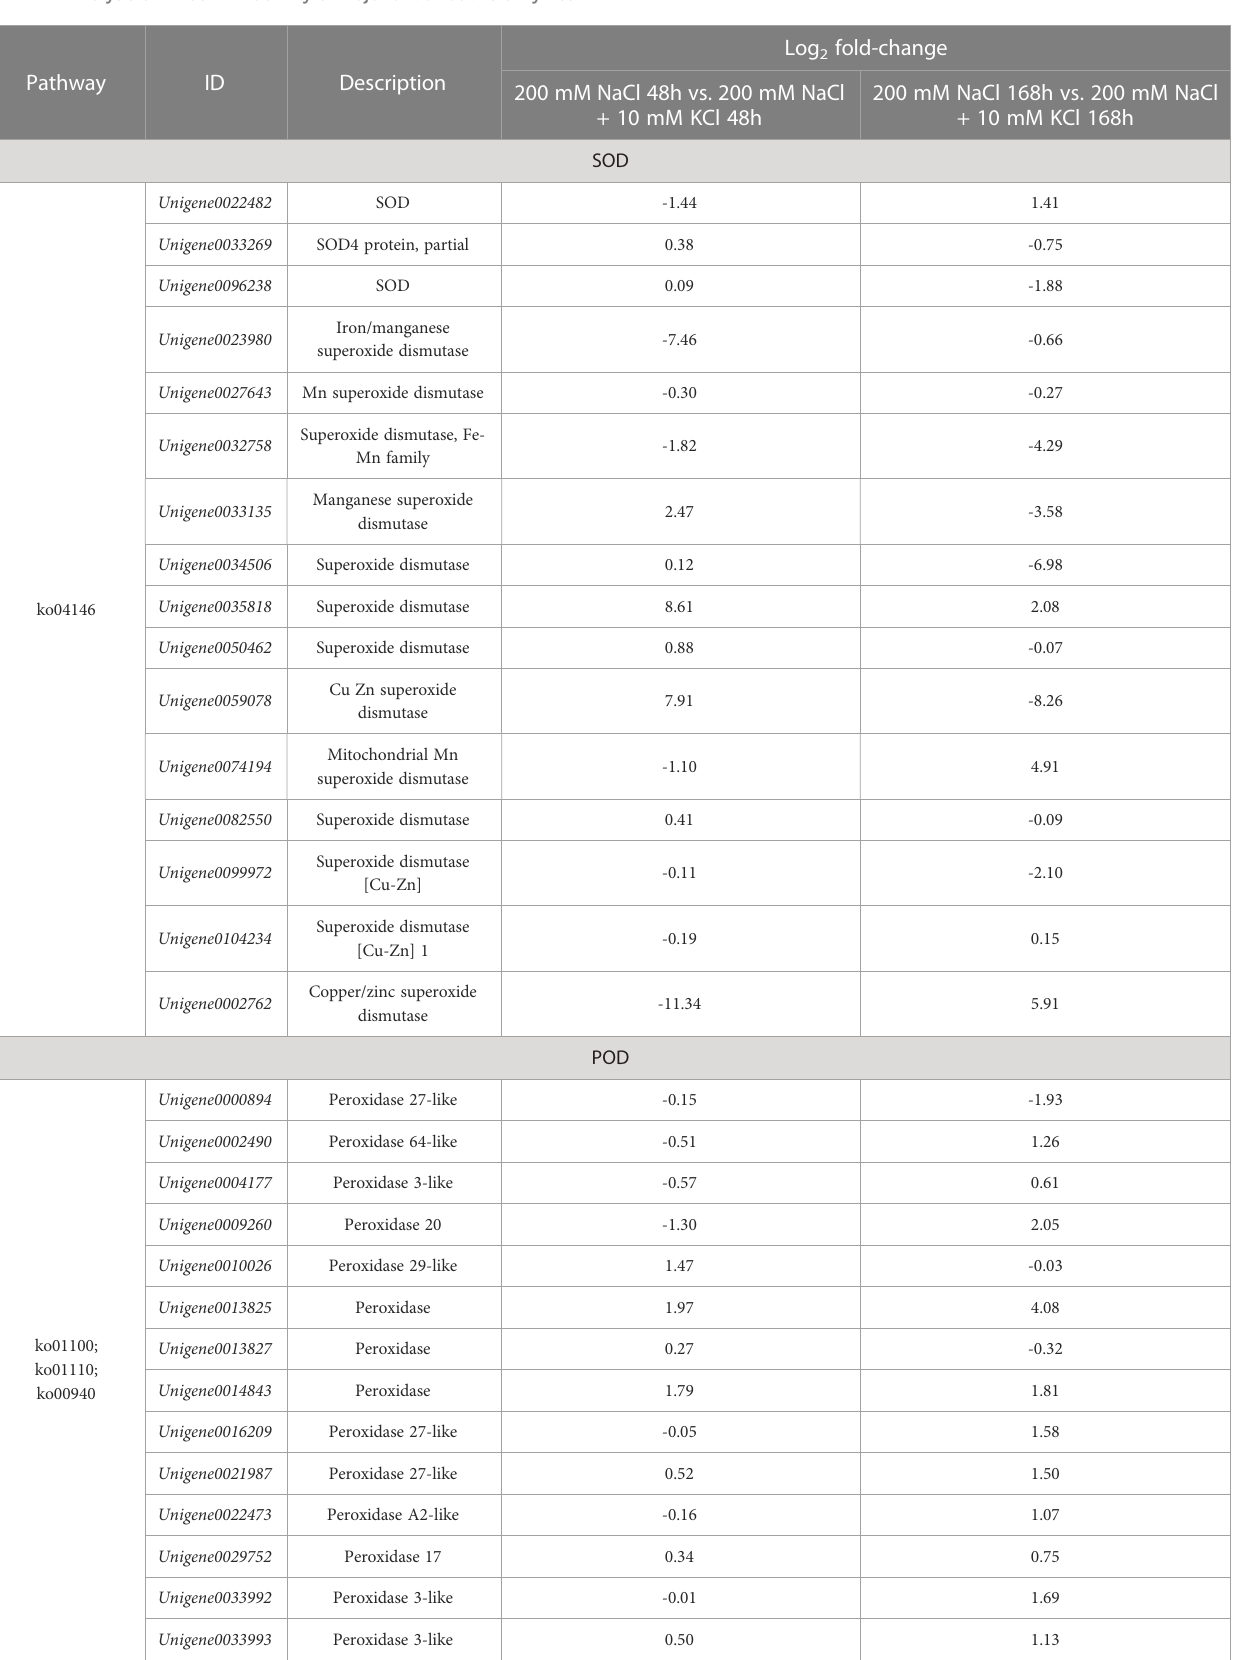
TABLE 1 Analysis of DEGs with activity of major antioxidative enzymes.